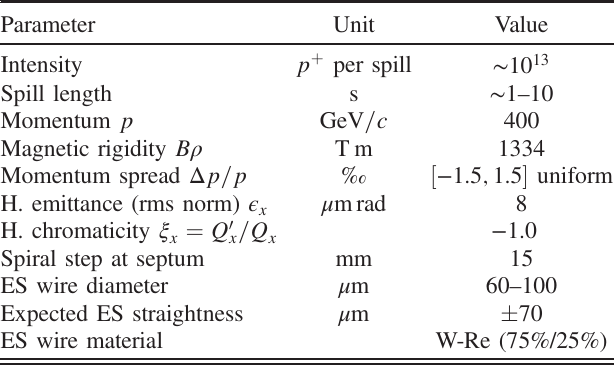
TABLE I. Accelerator and ES parameters for slow extraction at SPS.